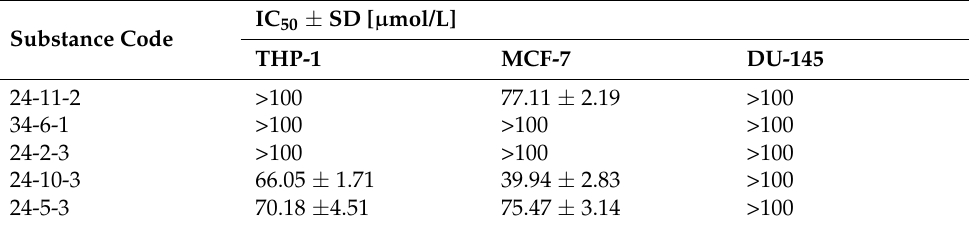
Table 4. Cell proliferation of three human cancer cell lines THP-1, MCF-7, and DU-145 and IC 50 values were evaluated using WST-1 analysis after 48 h incubation with serial dilutions of tested compounds. The values shown are the mean ± SD from three independent experiments, each performed in